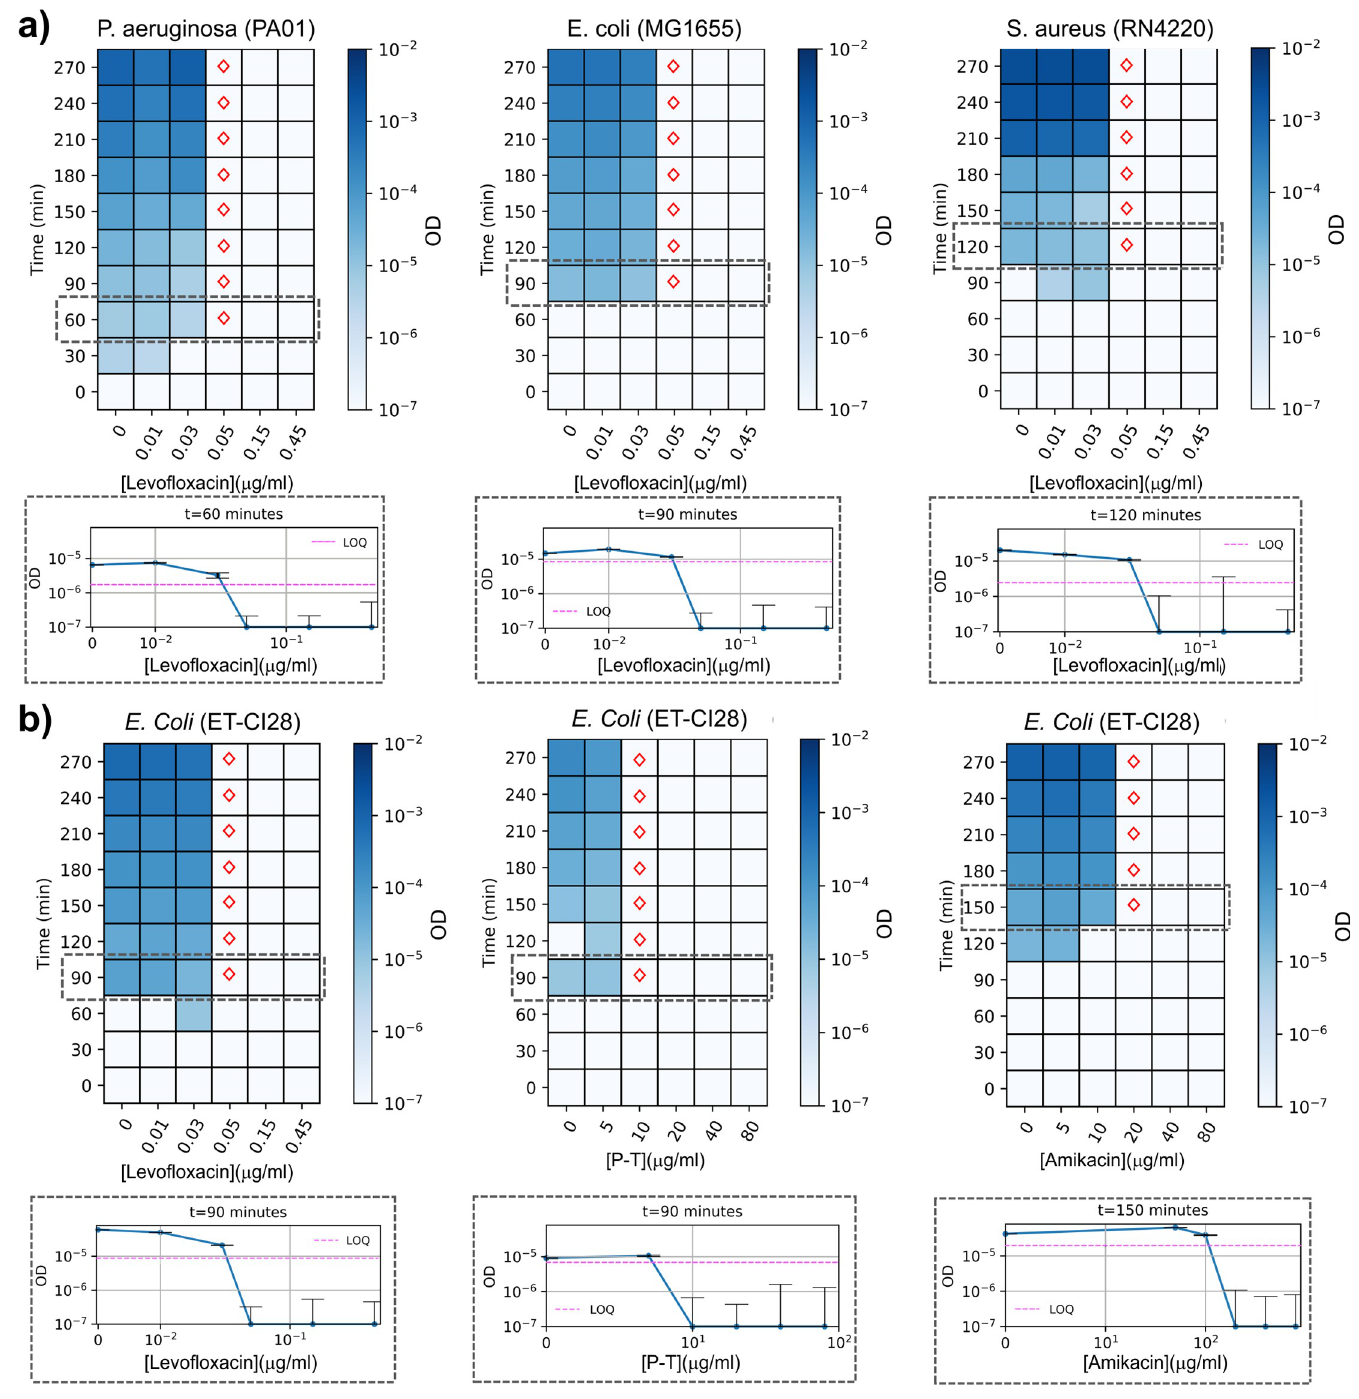
Fig 3. iFAST yields antibiotic resistance profile of pathogenic bacteria in 1 to 3 h. Bacterial cultures with initial OD of approximately 10 − 6 were grown in different concentrations of antibiotics, and their densities were periodically monitored in RUSD. Heat map plots show growth of bacteria as a function of time and antibiotic dosage. Colored bars indicate ODs of bacterial cultures. Red diamonds indicate MIC values measured at different time points at which bacterial growth is statistically significant (OD > LOQ). Below each heat map plot, a dose-response curve is provided for the first statistically significant MIC measurement. A calibration curve is generated for every strain before every measurement, and LOQ values are shown by using dashed magenta lines. (a) Time-resolved dose-response measurements for laboratory strains of P . aeruginosa (PAO1), E . coli (MG1655), and S . aureus (RN4220) in levofloxacin, a DNA gyrase inhibitor. (b) Time-resolved dose-response measurements for a clinical E . coli isolate (ET-CI28) in levofloxacin, P-T (a beta-lactam cell-wall synthesis inhibitor and beta-lactamase inhibitor), and amikacin (an aminoglycoside). (The data for Fig 3 can be found in S2 Data). iFAST, in Fiber Antibiotics Susceptibility Testing; LOQ, limit of quantification; MIC, minimum inhibitory concentration; OD, optical density; P-T, piperacillin-tazobactam; RUSD, rapid ultrasensitivity detector.